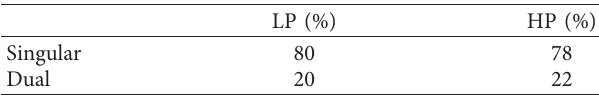
Table 8: Number substitution for nonhuman plural nouns by